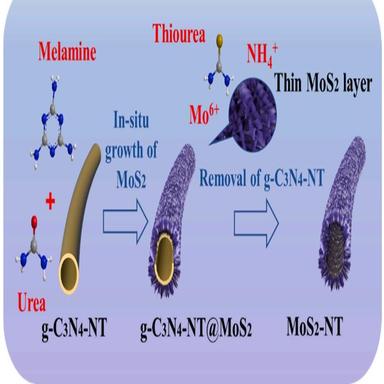
Schematic illustration of the synthesis process of MoS2 nanotube.